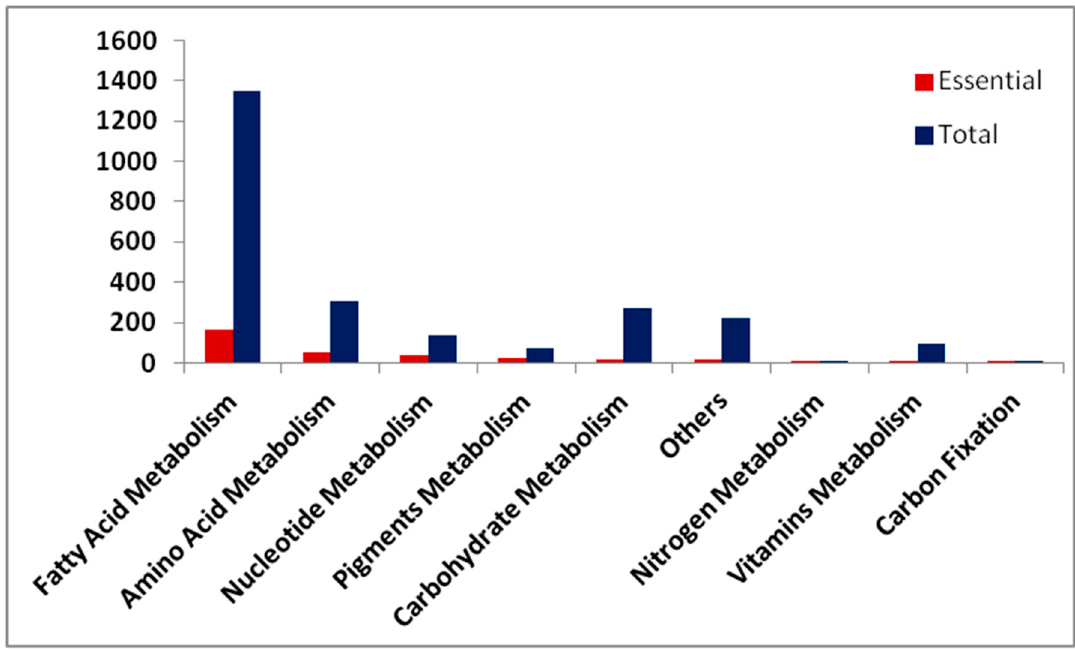
Figure 5. Distribution of total and essential reactions of the model across various subsystems.